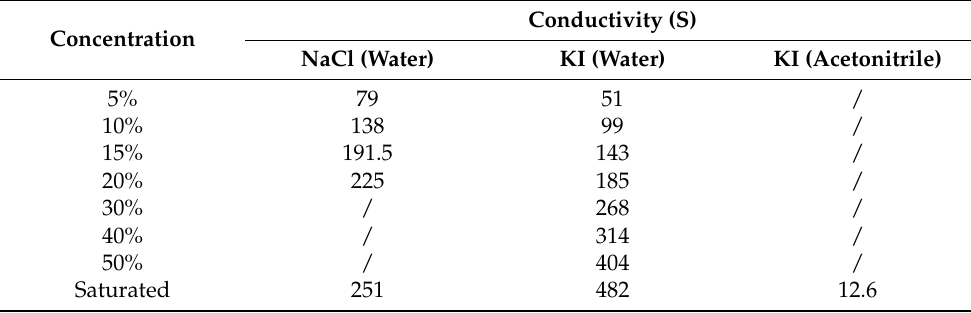
Table 2. Conductivity of the electrolyte in NaCl or KI